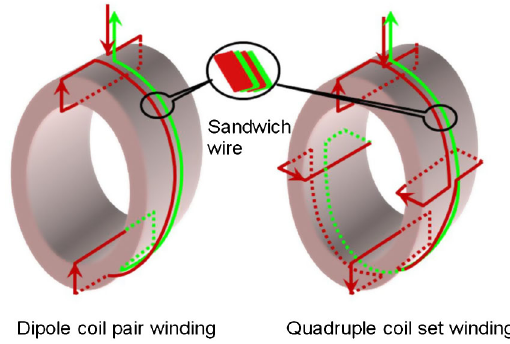
FIG. 6. Dipole and quadrupole windings.